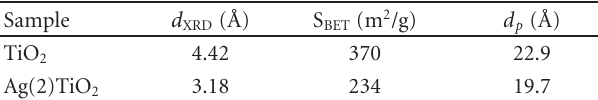
Table 1: Structural and textural properties of TiO 2 and Ag(2)TiO 2